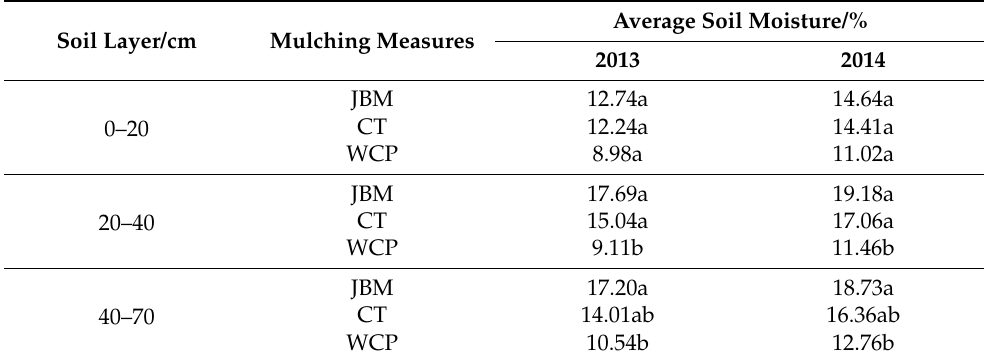
Table 2. Statistical properties of the vertical distribution of soil moisture in the 0–70 cm soil layer under different mulching